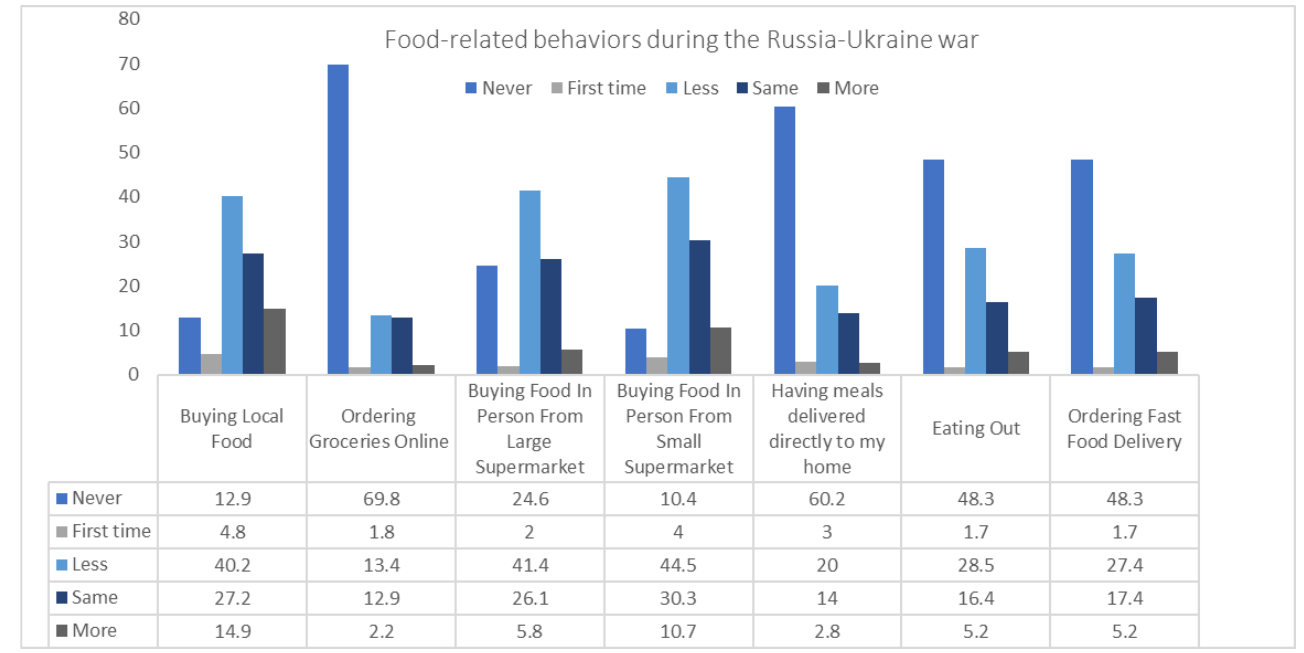
Figure 4. Changes in food-related behaviors during the Russia – Ukraine war .